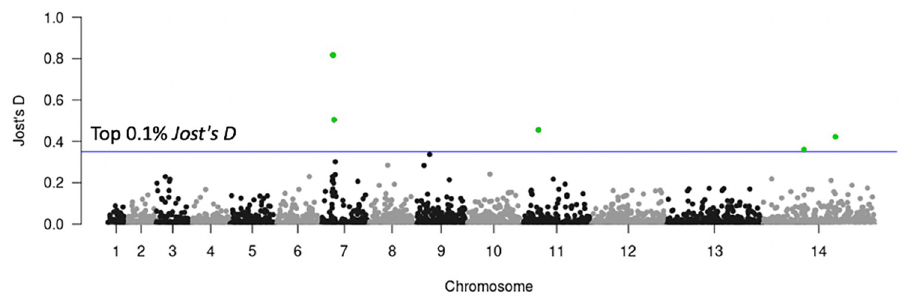
Fig 7. Genome scans for differentiation for chloroquine drug resistance using 57 EAF drug-resistant and 269 EAF drug-sensitive samples. The x-axis represents the chromosomes, and the y-axis represents the Jost’s D values. Each point represents one STR locus. The blue horizontal line represents the top 0.1% Jost’s D values.